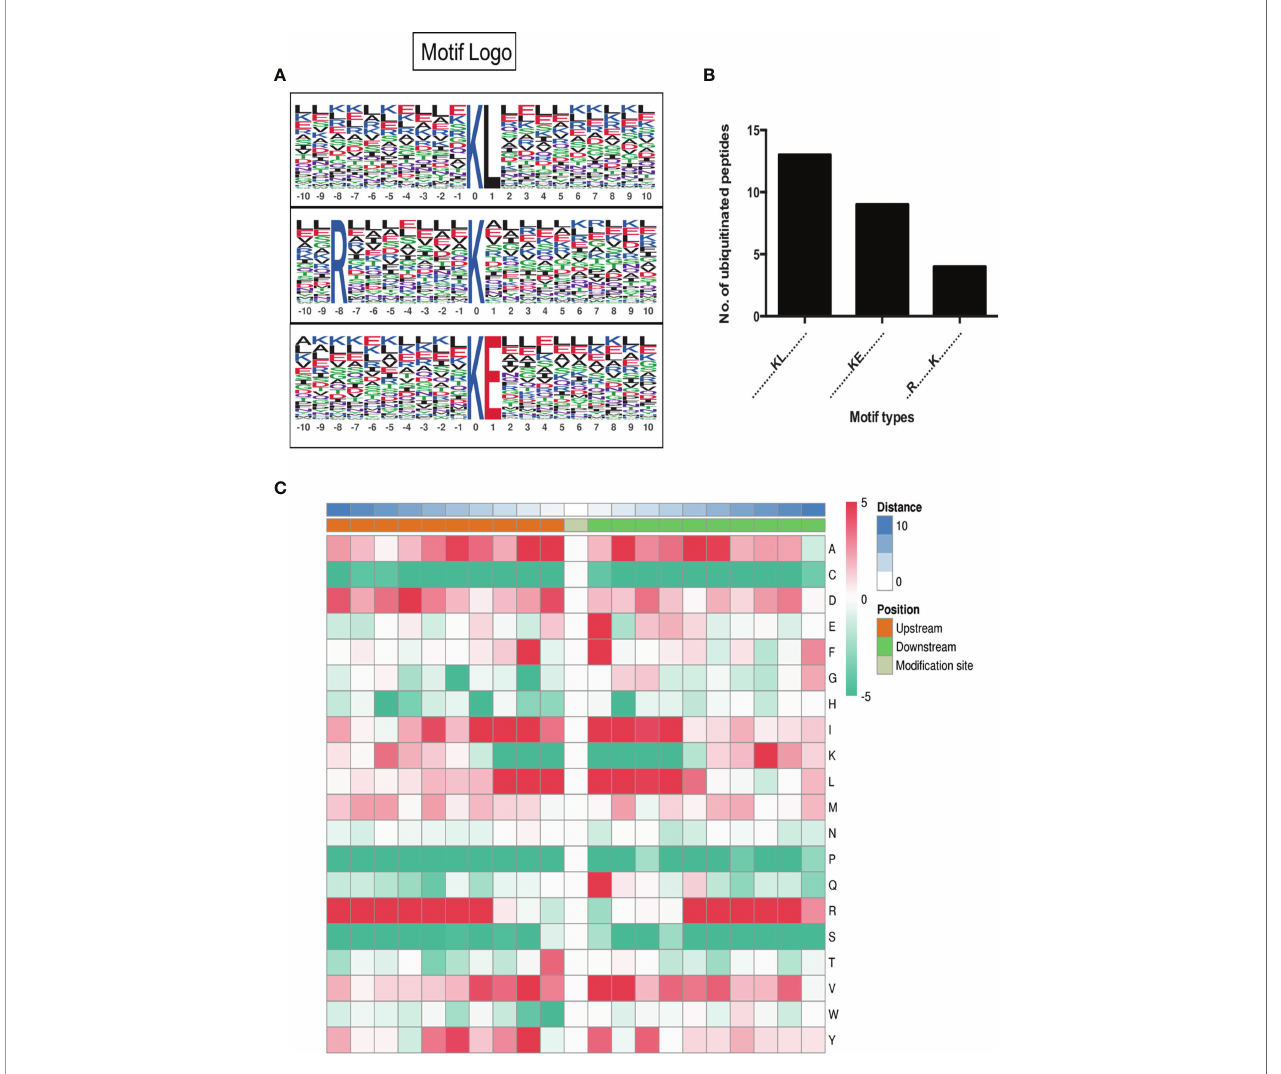
FIGURE 3 | Motif analysis of differently expressed ubiquitination sites. (A) Potential ubiquitin recognition motif logos. The height of each letter represents the frequency of the residue in that position. K in the middle represent for the ubiquitinated lysine. (B) The number of identi fi ed peptides among the three motifs. (C) The heatmap for the amino acid distribution fl anking ubiquitination